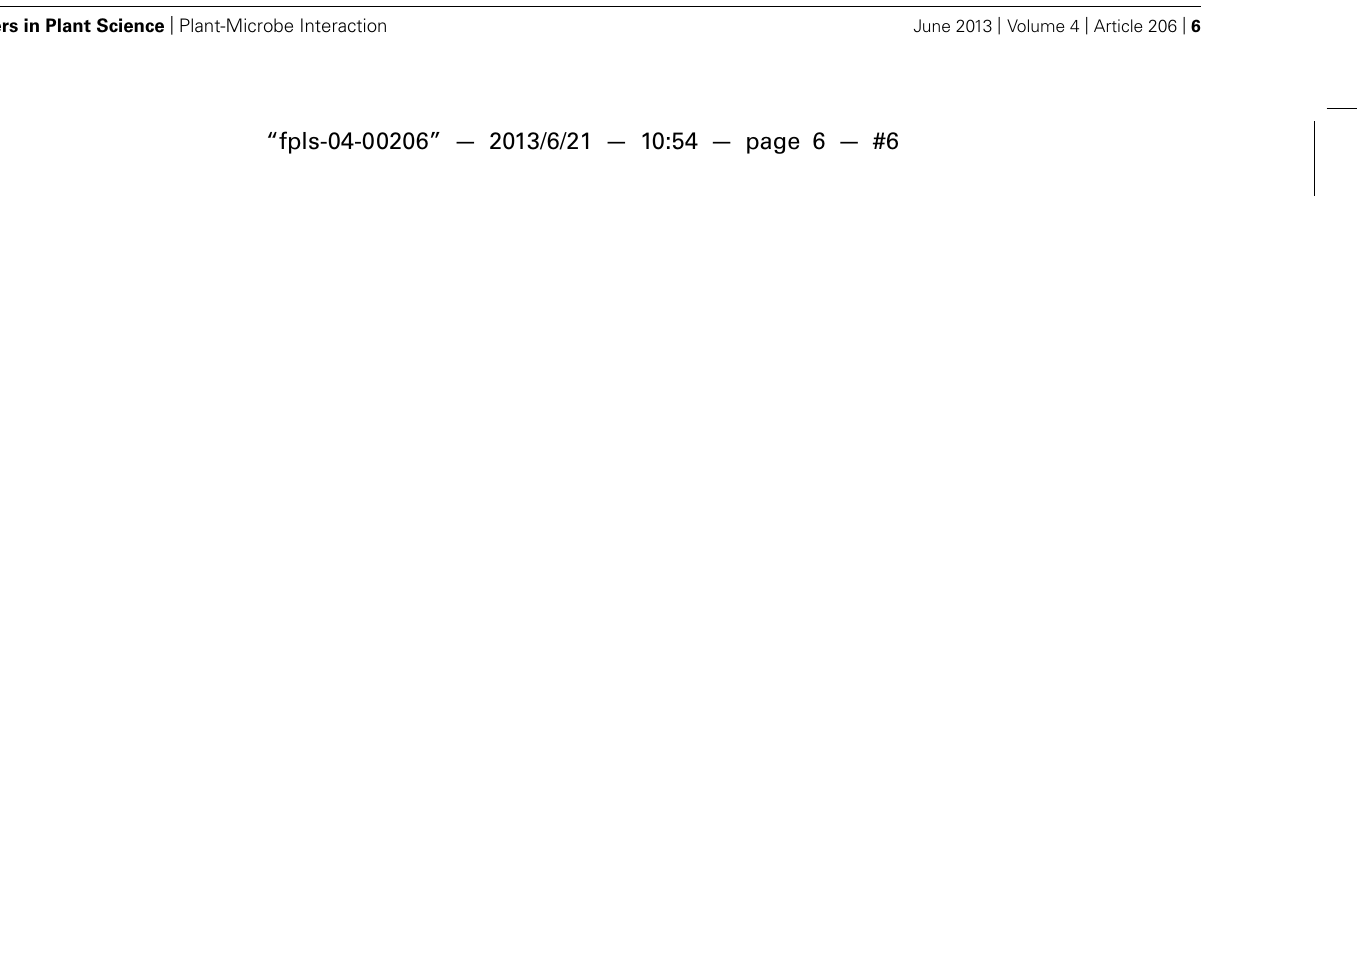
FIGURE 2 | Trichoderma -induced systemic resistance requires JA, SA, andABA. Lesion diameter was measured 96 h after challenge with the pathogen in (A) the wild-type tomato plants cv. Castlemart and the JA-impaired mutant def1 ; (B) in the wild-type cv. Moneymaker and the SA- and ABA-impaired mutants NahG and sitiens , respectively; (C) in the